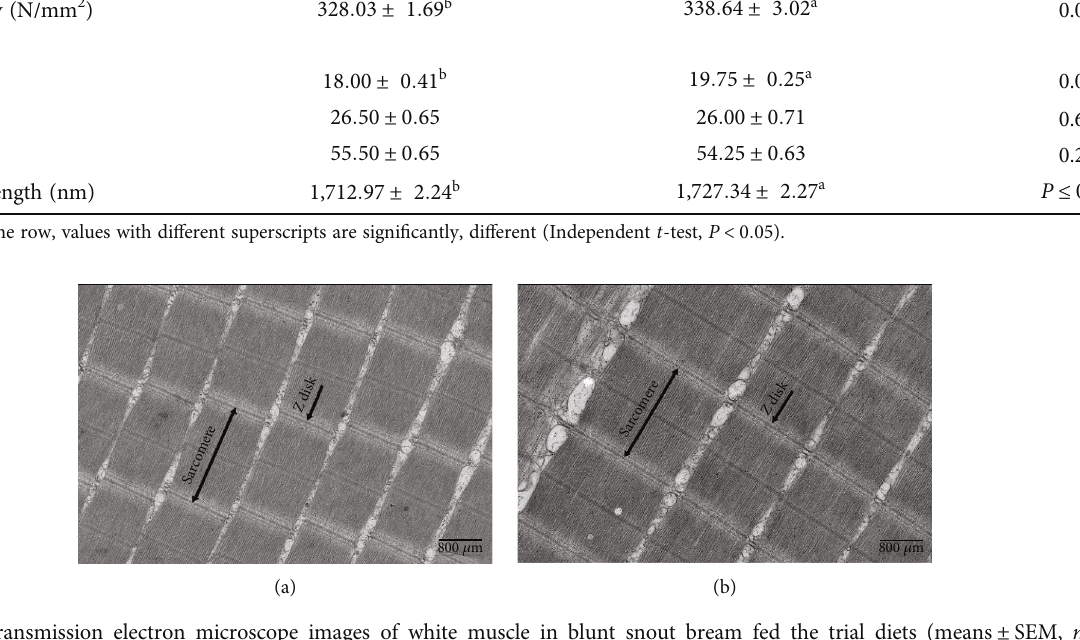
Figure 2: Transversal section of white muscle of blunt snout bream fed the trial diets ( means ± SEM , n = 4 ). Photomicrographs ( × 100 ) and scale bar (100 μ m). The morphology of muscle fi ber is irregular polygons. (a) fi sh fed LL diets; (b) fi sh fed HL diets. Table 6: Muscle cellularity and sarcomere length of blunt snout bream fed the trial diets ( Mean ± SEM , n = 4 ). Texture